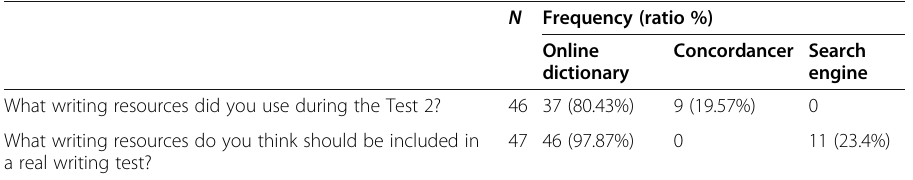
Table 10 Type of online resource features favored by test